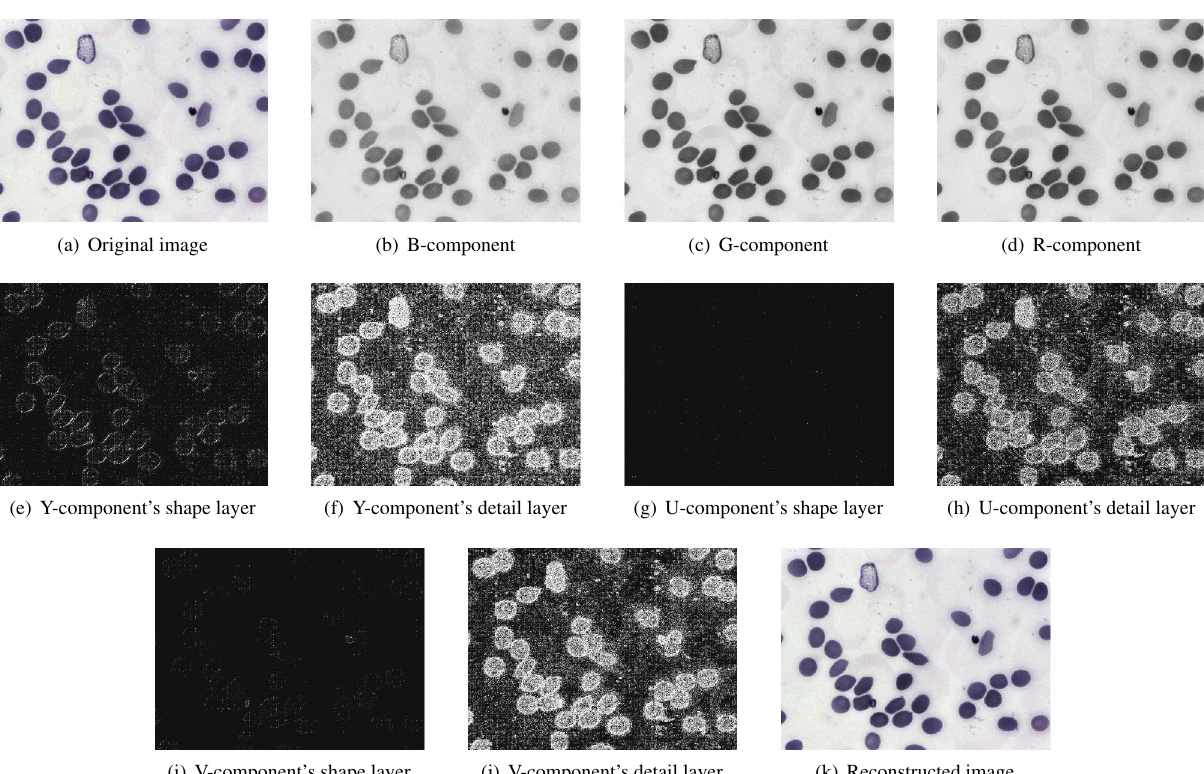
Figure 3. An instance of Malaria dataset by using soft compression algorithm for multi-component image. ( a ) The original RGB image. ( b ) B-component image. ( c ) G-component image. ( d ) R-component image. ( e ) The shape layer of Y-component. ( f ) The detail layer of Y-component. ( g ) The shape layer of U-component. ( h ) The detail layer of U-component. ( i ) The shape layer of V-component. ( j ) The detail layer of V-component ( k ) The reconstructed image by